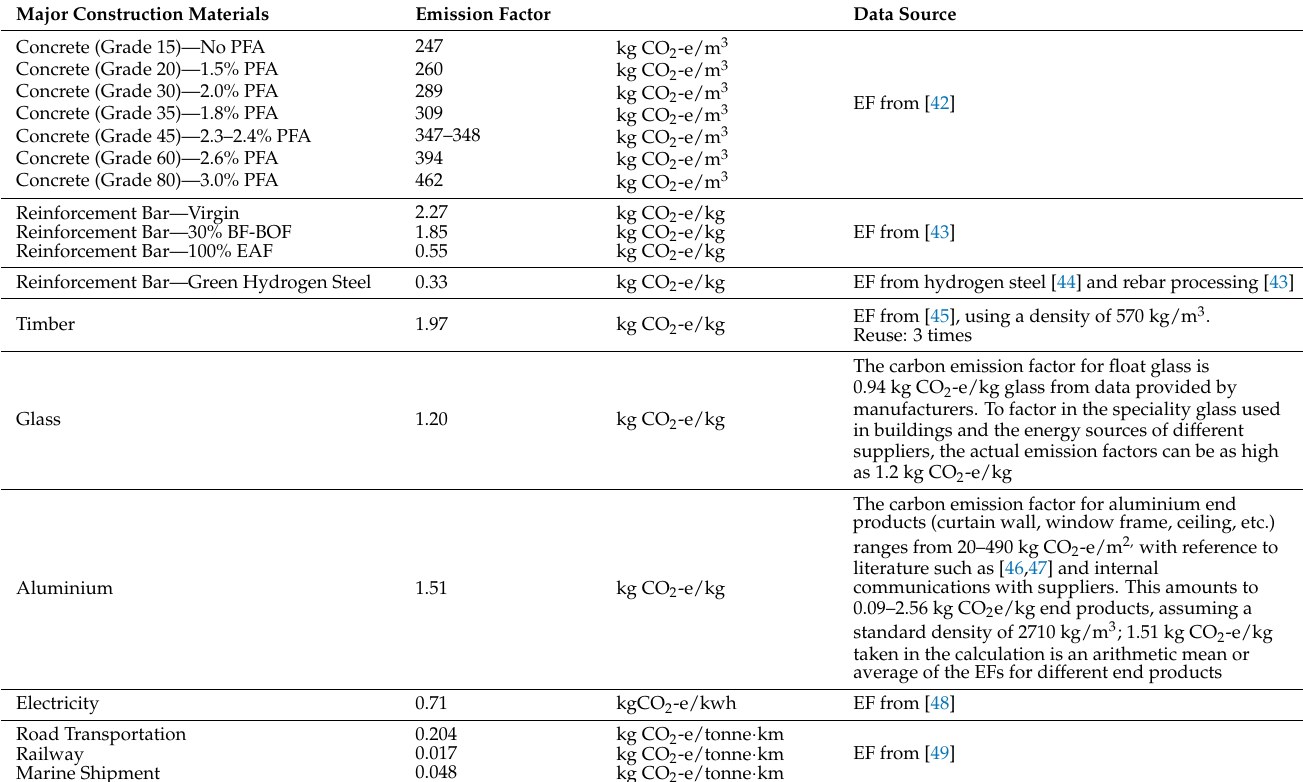
Table 2. Embodied carbon emission factor for different building